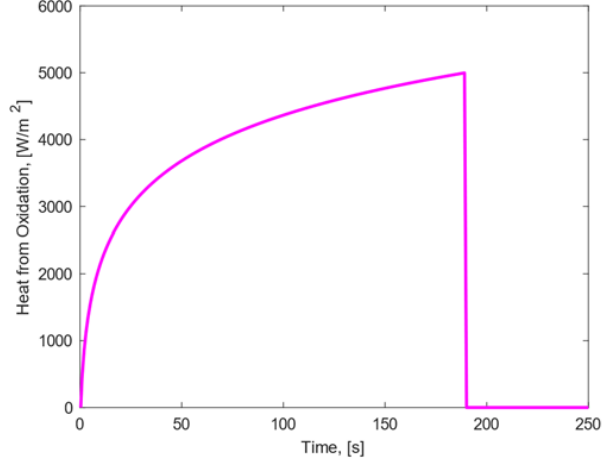
Figure 5. Heat release by surface oxidation of stainless steel 316L.